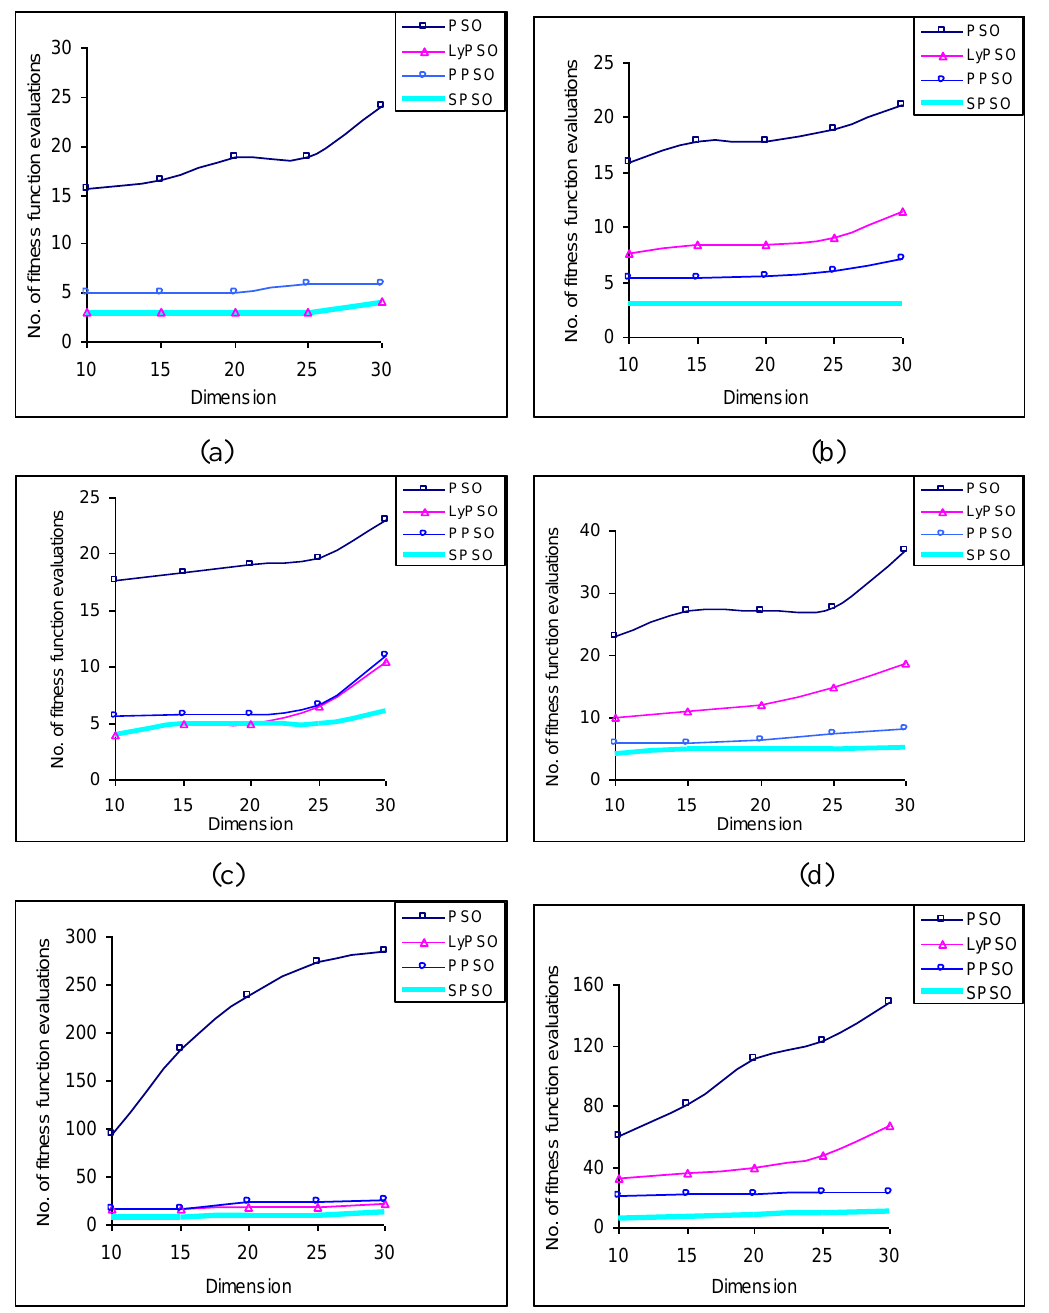
Figure 3. Variation in number of fitness function evaluations with function dimension: (a) Sphere function. (b) Rosenbrock’s function. (c) Step function. (d) Schwefel’s Problem 1.2. (e) Rastrigin’s function. (f) Ackley’s function. (g) Griewank’s function. (h) Salomon’s